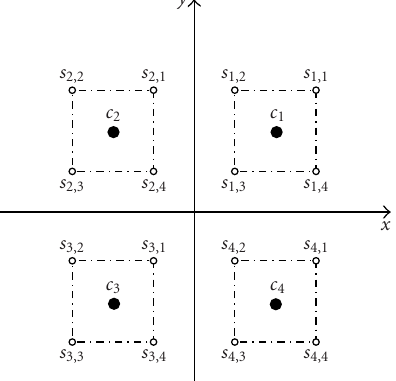
Figure 1: The multilevel structure of the 16-QAM modulation used in digital communications. The set of transmitted symbol A 1 = { s = 1, ... ,4, j = 1, ... ,4 } is the original sampling space, and i , j , i the centers A 2 = { c 1 , c 2 , c 3 , c 4 } constitute a higher-level sampling